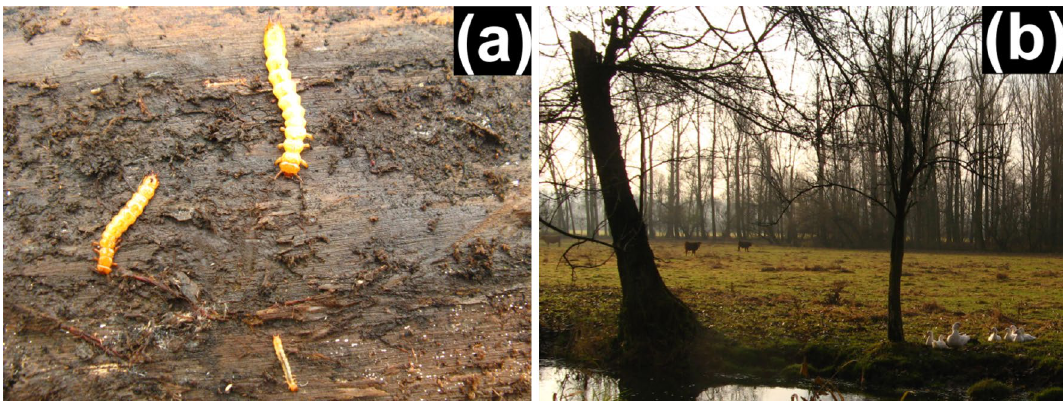
Figure 1. Study species and their habitat. ( a ) Illustration of the cooccurrence of all three studied species, with a larva of Cucujus cinnaberinus on the left, one of Pyrochroa coccinea at the top and one of Schizotus pectinicornis at the bottom. ( b ) View of the habitat where all three species cooccurred in the Czech